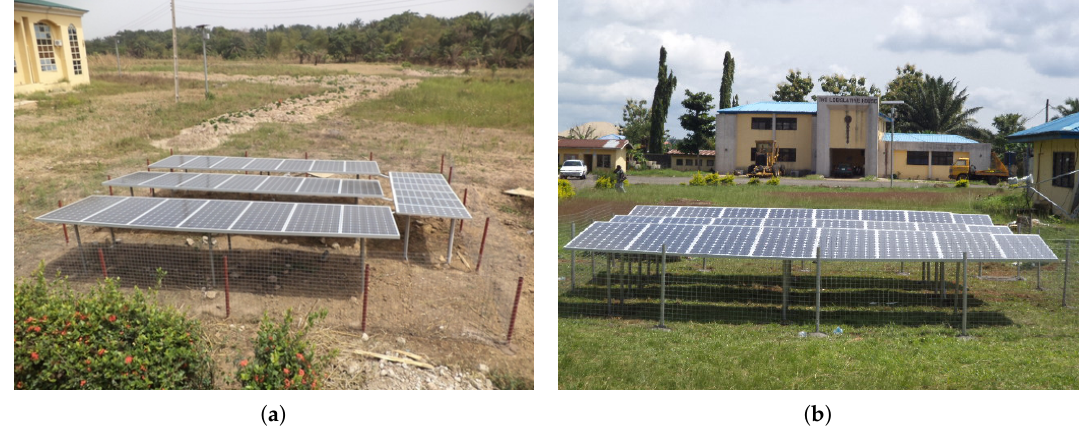
Figure 1. Examples of solar photovoltaic (PV) microgrids with battery banks and inverter controllers. ( a ) 4.4 kW solar microgrid for Aninri Local Government; ( b ) 4.2 kW solar microgrid for Atakumosa Local